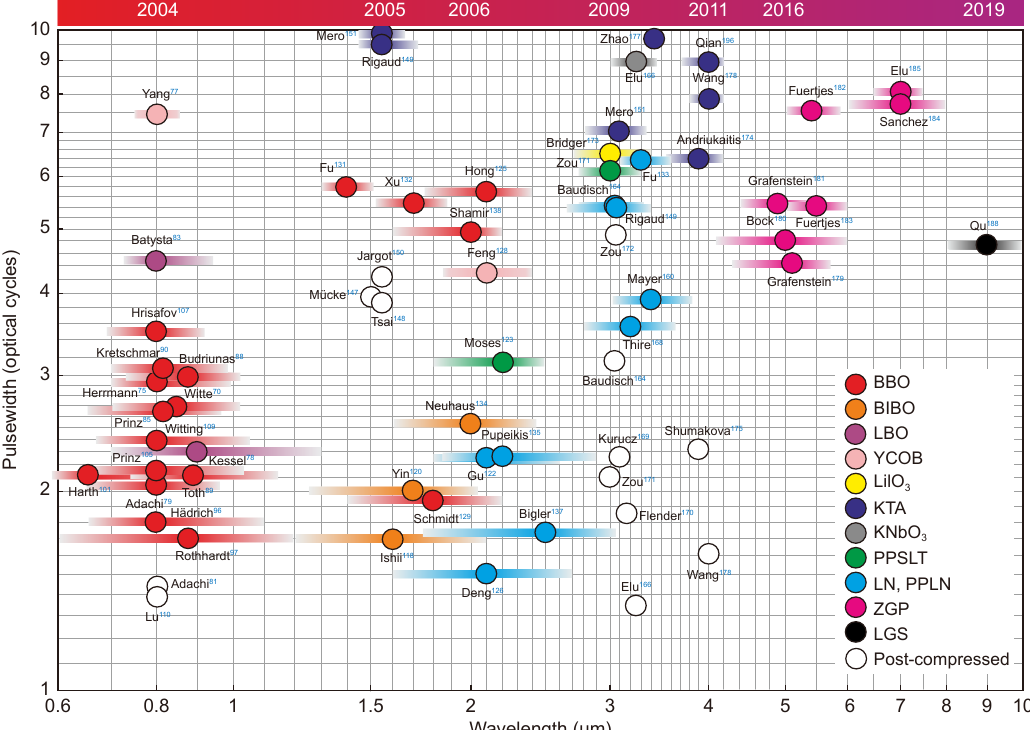
Fig. 2 | State of the art of few optical cycle table-top OPCPA systems. The central wavelength is indicated by colored circles, where color coding denotes the nonlinear crystal used as an amplifying medium. The amplified bandwidths are schematically depicted by horizontal bars, which represent the full width of the amplified spectrum. The time bar on the top marks the year of experimental inception of OPCPA in the partic- ular wavelength